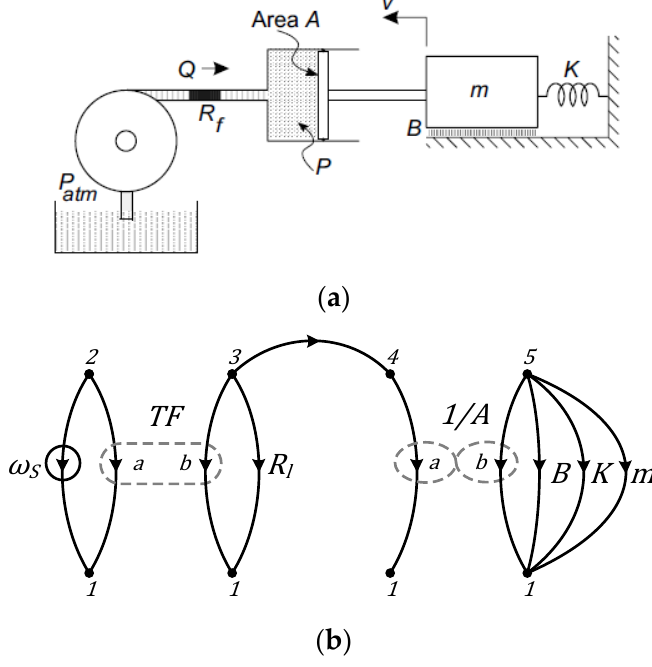
Figure 2. ( a ) System model and ( b ) LG model.